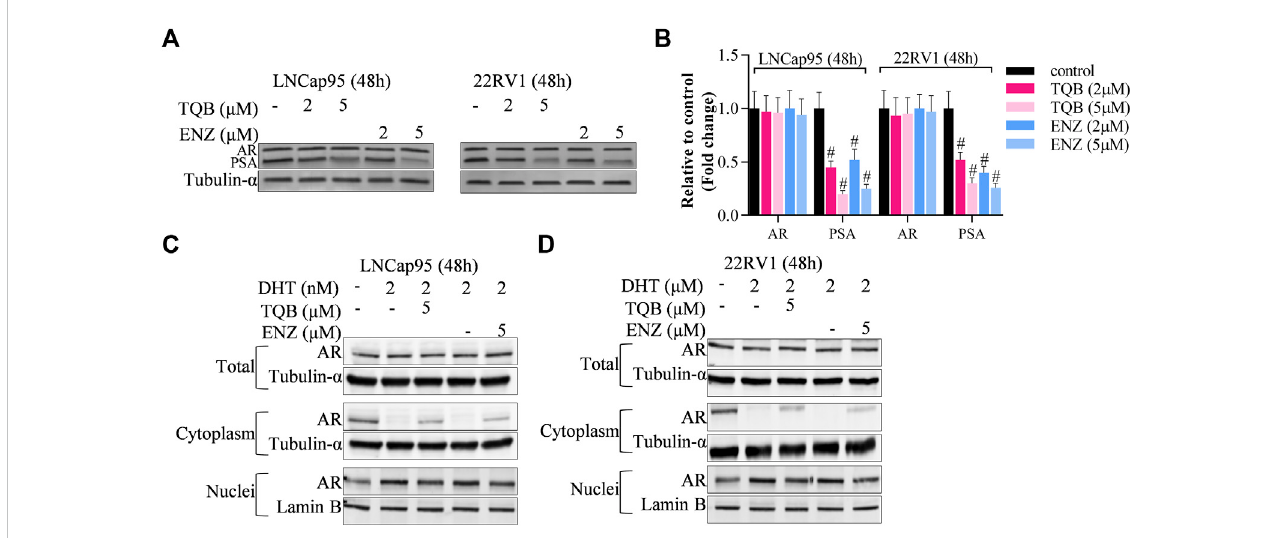
FIGURE 4 TQB3720 inhibited downstream of AR signaling by inhibiting AR entry into the nucleus (A, B) Western blot examined the effects of TQB3720 and ENZ on PSA expressions, and the protein band density was determined using ImageJ software, # p < 0.01 vs. control (absence of any indicated chemicals). (C,D) Western blot examined the effects of TQB3720 and ENZ on AR entry into nuclei from cytoplasm, and the protein band density was determined using ImageJ software, # p < 0.01 vs. control (absence of any indicated chemicals).